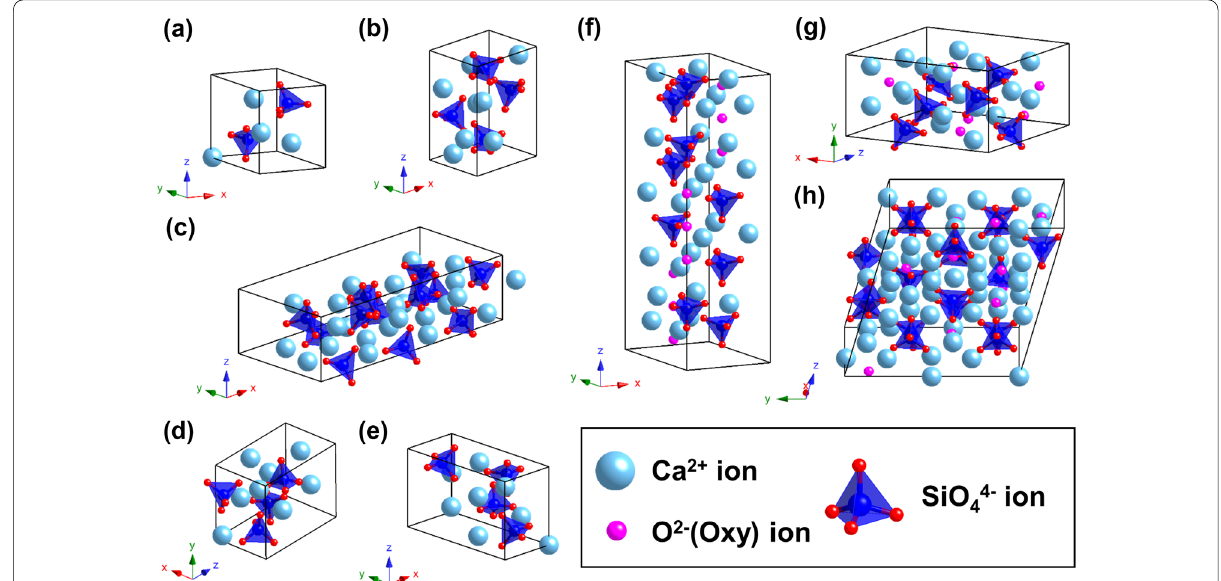
Fig. 3 Unit cells of crystal structures with optimized atomic positions of a α-C 2 S, b α’ H -C 2 S, c α’ L -C 2 S, d β-C 2 S, e γ-C 2 S, f R-C 3 S, g M3-C 3 S and h T1-C 3 S.